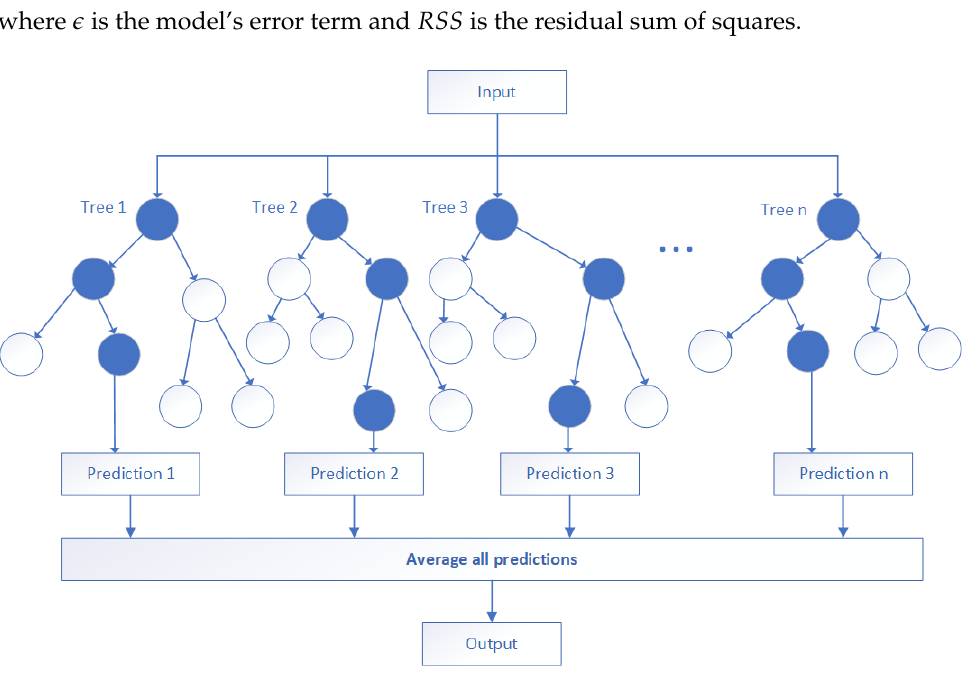
Figure 2. Structure of an RF model with n